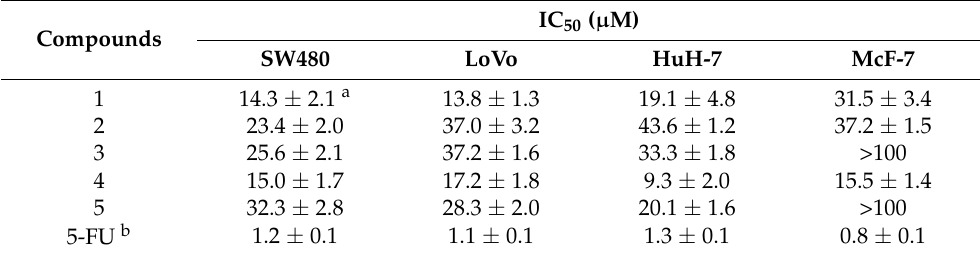
Table 3. In vitro antitumor activity of compounds.